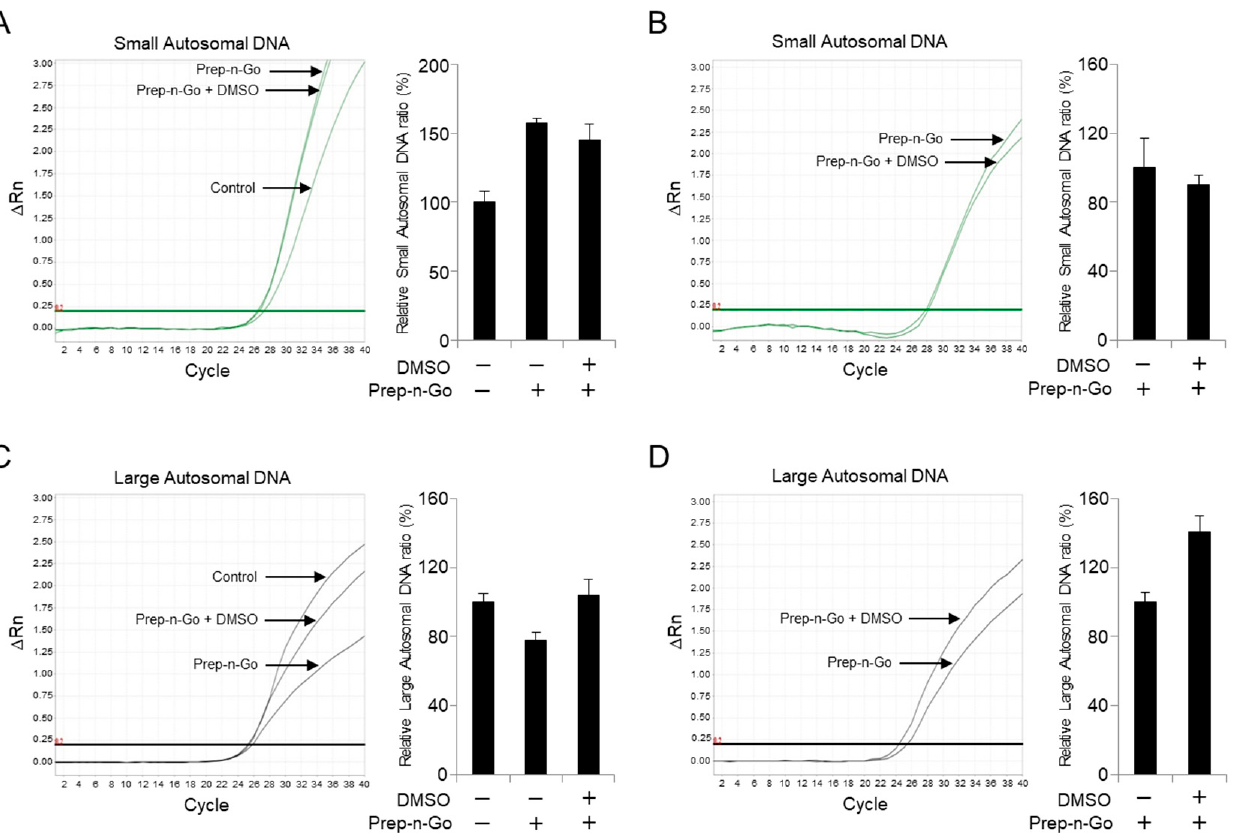
Figure 3. Quantitative analysis of small or large autosomal DNA by dimethyl sulfoxide (DMSO) amplified using direct polymerase chain reaction (PCR). Quantitative analysis of the amplified DNA was performed using small or large autosomal DNA (amplicon size: 80 or 214 bp, respectively) included in the Quantifiler Trio DNA Quantification Kit in 2800M DNA ( A , C ) and 1.2 mm-punched saliva samples ( B , D ). Data represent mean ± standard deviation.